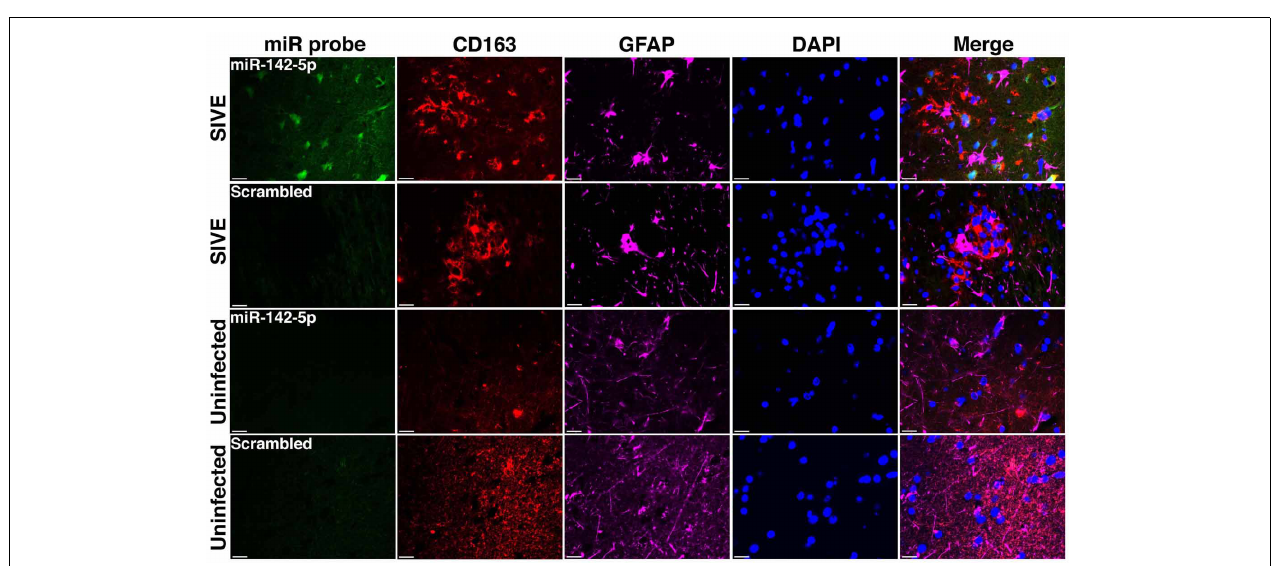
MAP2-labeled neurons (red) only in sections from macaques with SIVE. No miRNA-142-5p signal was detected in uninfected control sections. A scrambled miRNA probe was used as negative control for hybridization. Scale bars are 20 µ m.